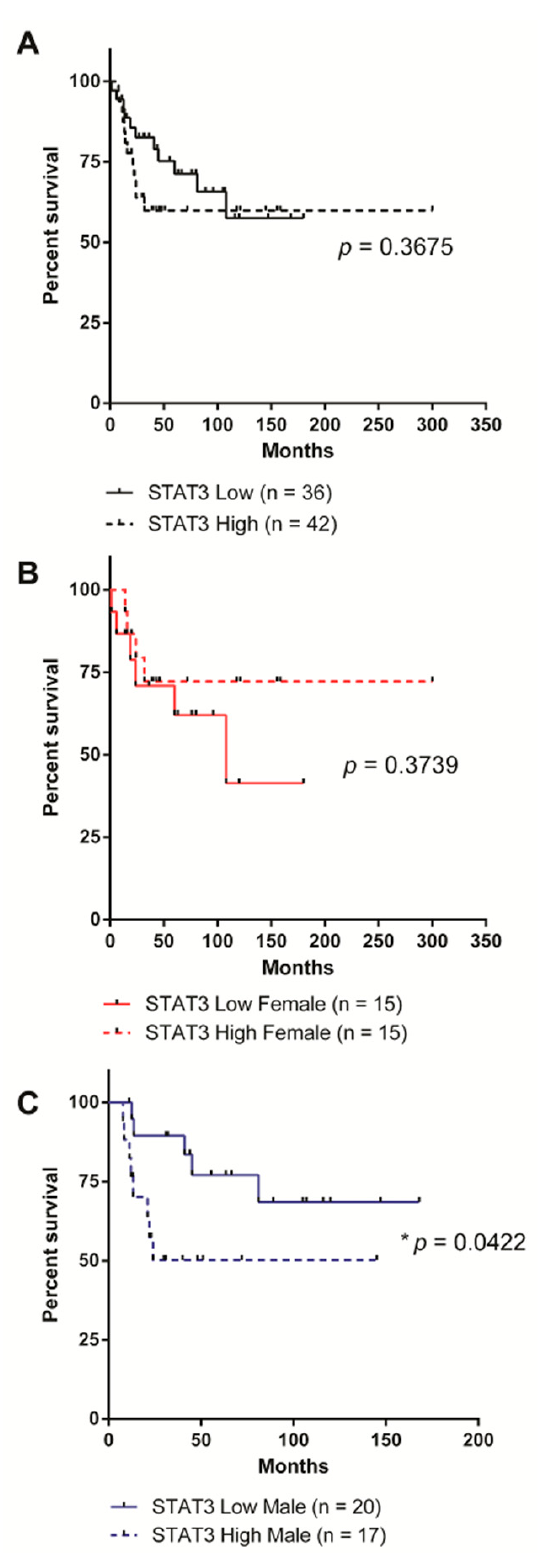
Figure 3. Low STAT3 expression correlates with improved survival in male SHH MB patients. ( A ) All patients were stratified by STAT3 levels prior to Kaplan-Meier survival analysis. Patients with low STAT3 (n = 36) and high STAT3 (n = 42) had similar survival ( p = 0.3675). ( B ) When only female patients were analyzed, patients with high (n = 15) and low (n = 15) STAT3 still showed similar survival ( p = 0.3739). ( C ) When only male patients were analyzed patients with low STAT3 (n = 20) showed significantly improved survival relative to those with high STAT3 (n = 17, p =